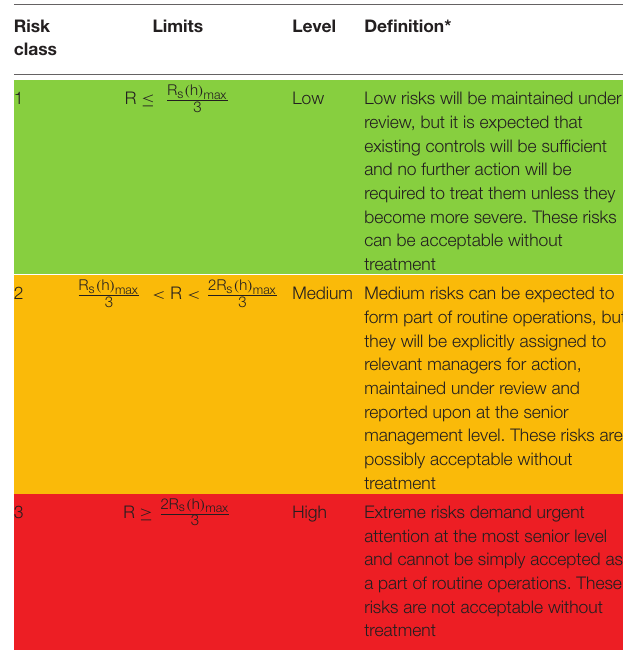
TABLE 2 | Multi-hazard Risk